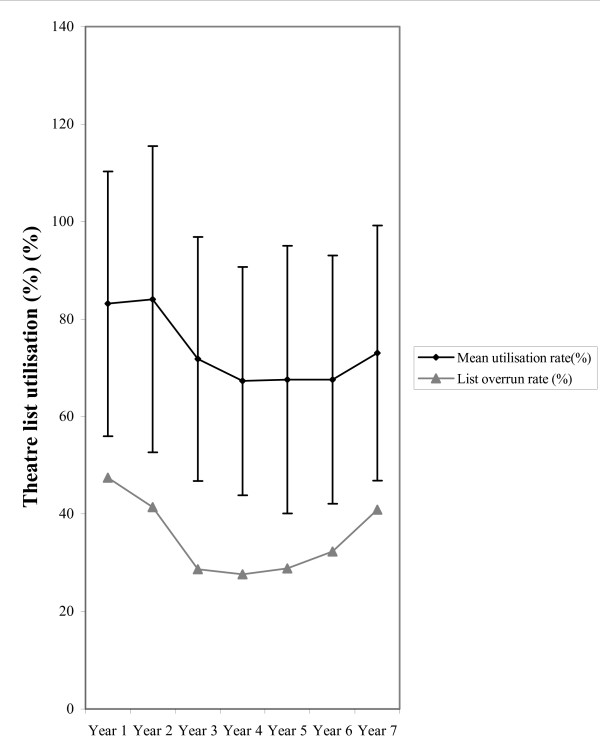
Mean utilization (+SD) and annual overrun rates for main theatre general surgical lists between 1997 & 2004.